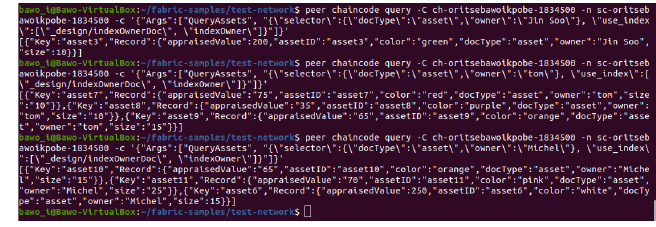
Figure 11: Rich query based on key–value